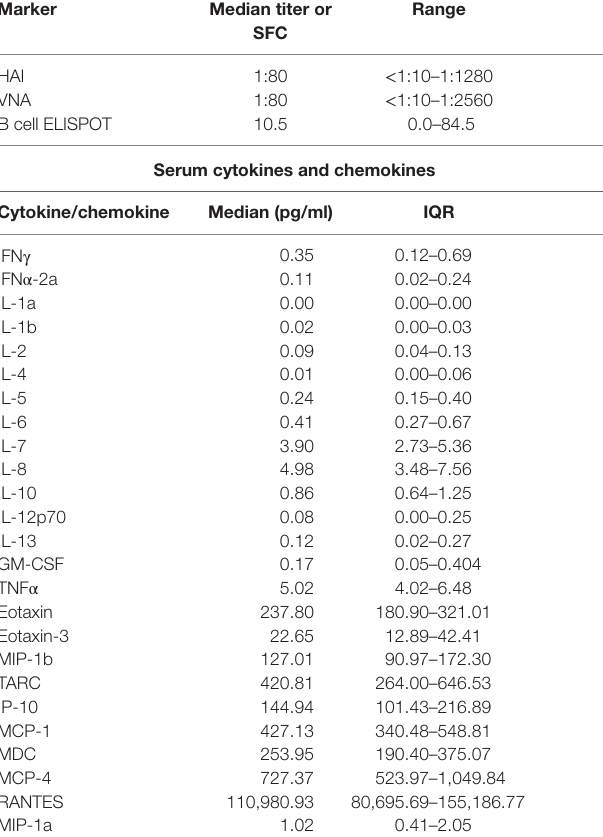
TaBle 1 | Distribution of immunosenescence and immunologic markers.